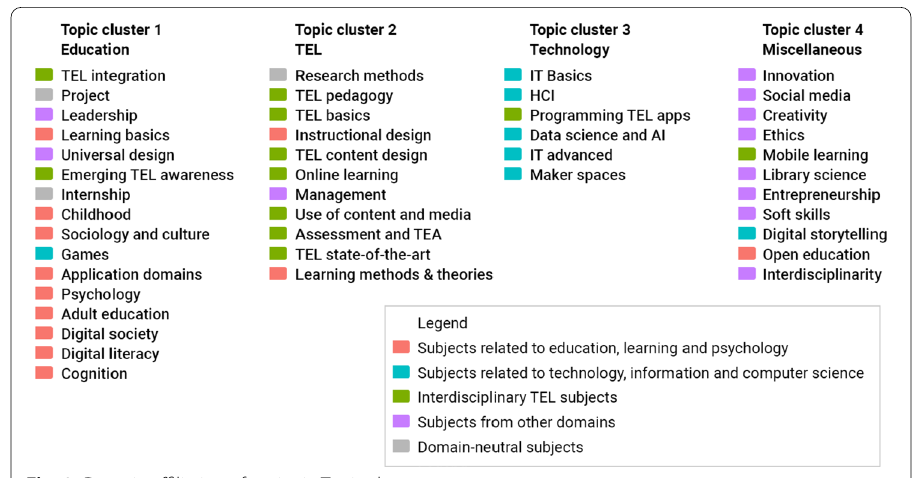
Fig. 8 Domain affiliation of topics in Topic